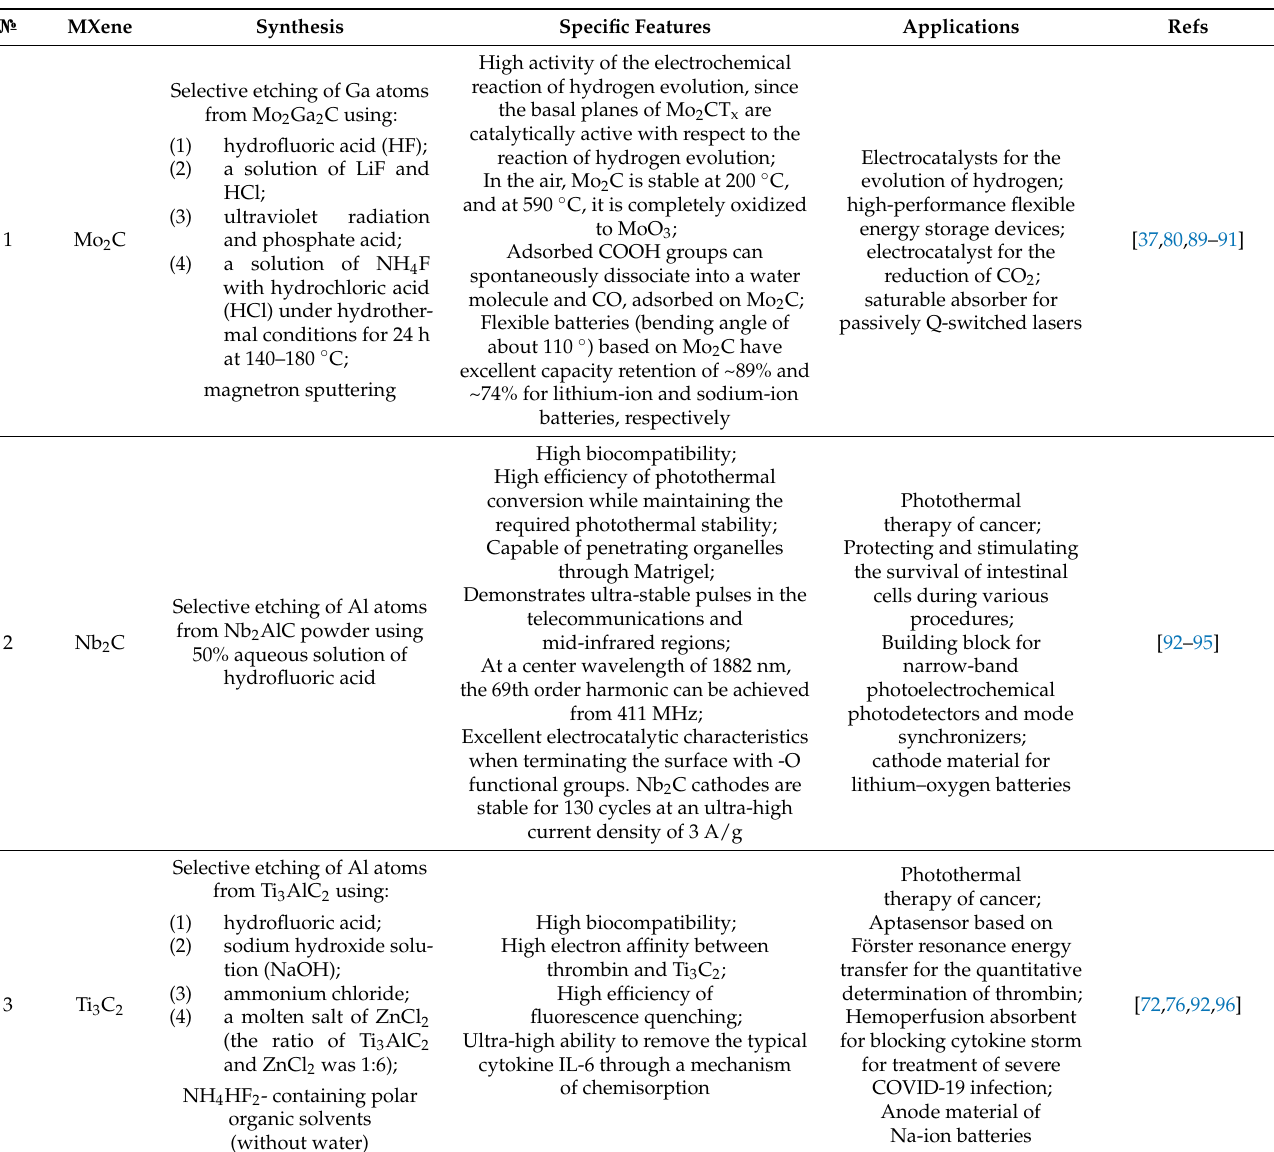
Table 1. A list of various MXenes known to date with their features and possible